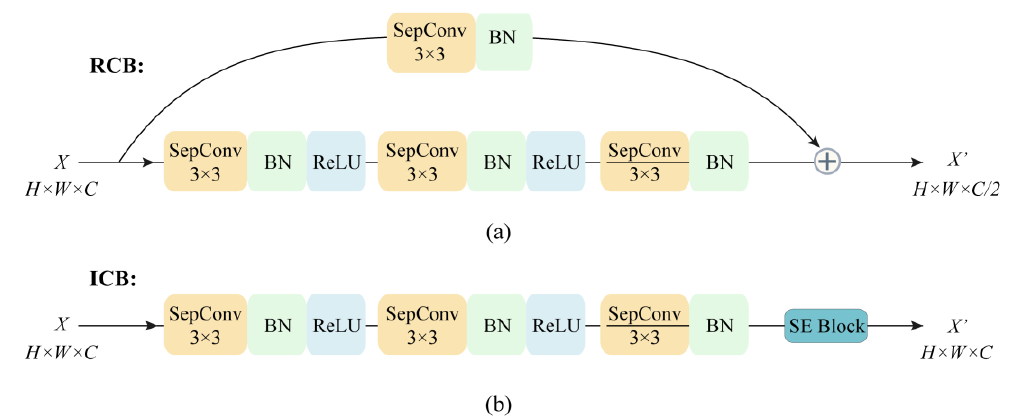
Figure 2. Two types of convolutional block in the backbone network. ( a ) Residual convolutional block with skip connections (Stride = 2). ( b ) Identity convolutional block (Stride = 1).